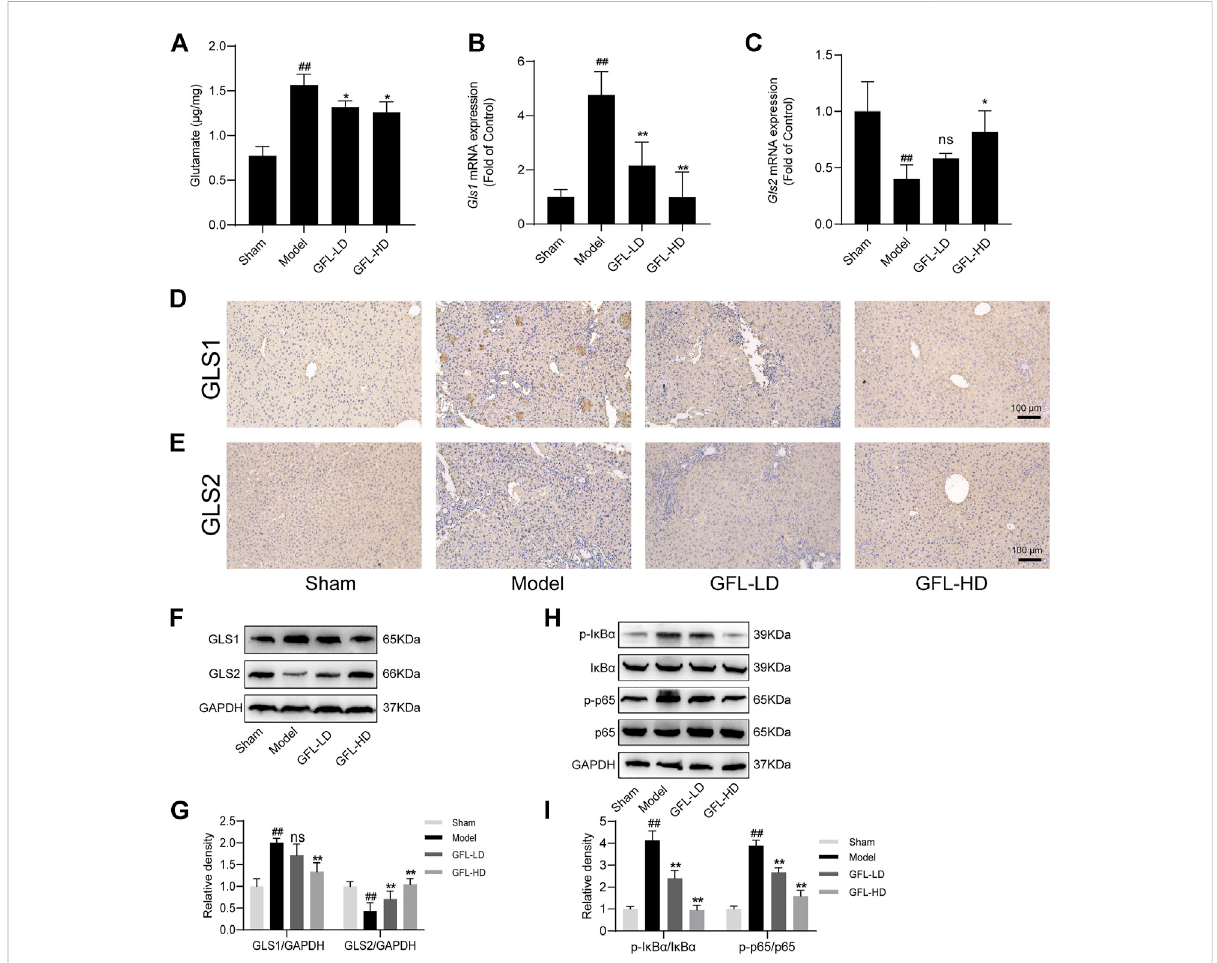
FIGURE 6 GFLregulationofglutaminemetabolismbytheNF- κ Bpathway. (A) Glutamatecontentintheliver.mRNAexpressionof (B) GLS1and (C) GLS2in the liver. Representative (D) GLS1 and (E) GLS2 immunohistochemical images of liver tissue sections (×200 magni fi cation). (F) Protein expression of GLS1 and GLS2 in the liver. (G) Protein expression statistics of GLS1 and GLS2. (H) Protein expression of the NF- κ B pathway in the liver. (I) Protein expression statistics of the NF- κ B pathway. Data are expressed as the mean ± SD, n = 3. Data were analyzed using one-way ANOVA. # p < 0.05, ## p < 0.01 compared to the sham group. * p < 0.05, ** p < 0.01 compared to the model